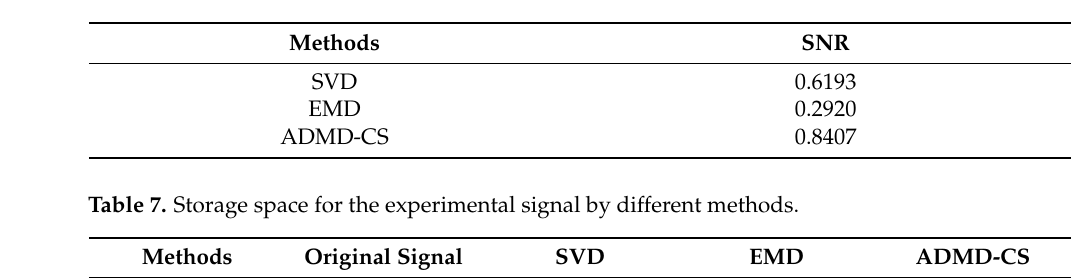
Figure 12. Frequency domains comparison of various algorithms. ( a ) Original signal; ( b ) SVD; ( c ) EMD; ( d ) ADMD-CS. Table 6. SNR of the recovered and original signals, after processing experimental signal by different methods.